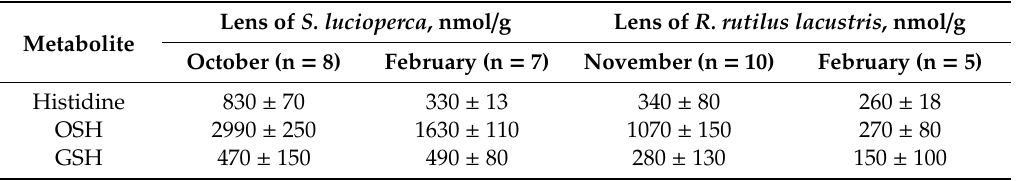
Table 1. Concentrations of histidine, ovothiol and glutathione in lenses of S. lucioperca and R. rutilus lacustris (in nmoles per gram of the lens wet weight). Values are expressed as mean ± standard deviation. Lens of S. lucioperca , nmol / g Lens of R. rutilus lacustris , nmol / Metabolite